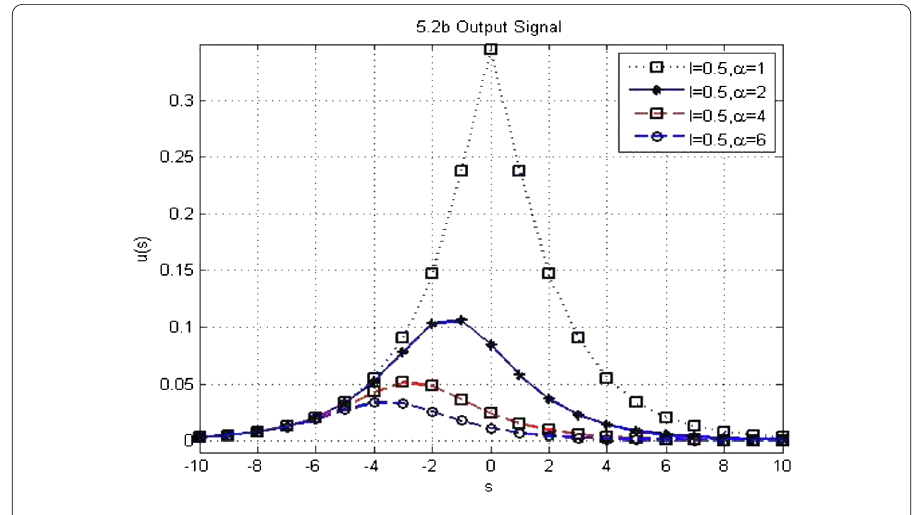
Figure 3 Output signal for (cid:5) = 0.5 and α